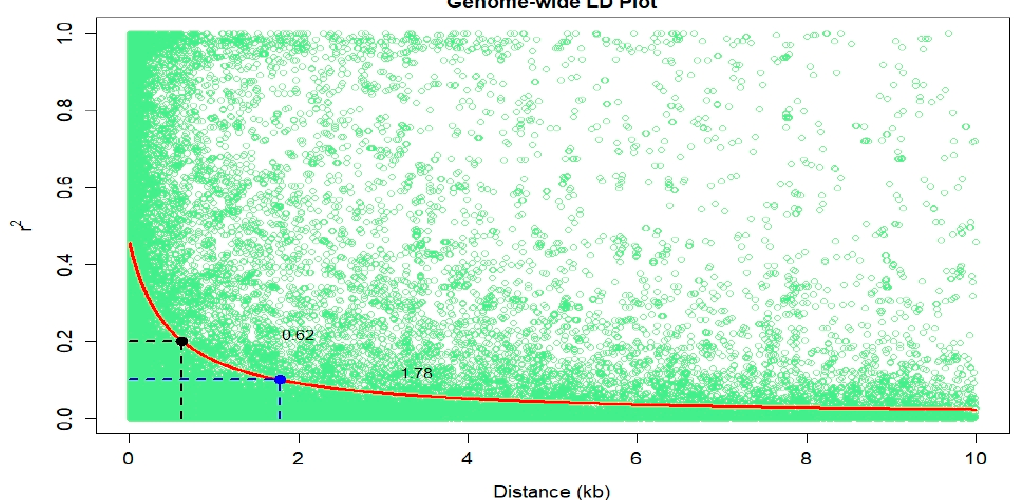
Figure 3. Linkage disequilibrium (LD) plot representing the average genome-wide LD decay in the panels with genome-wide markers. The values on the y-axis represents the squared correlation coefficient r 2 and the x -axis represents the physical distance in (kb).